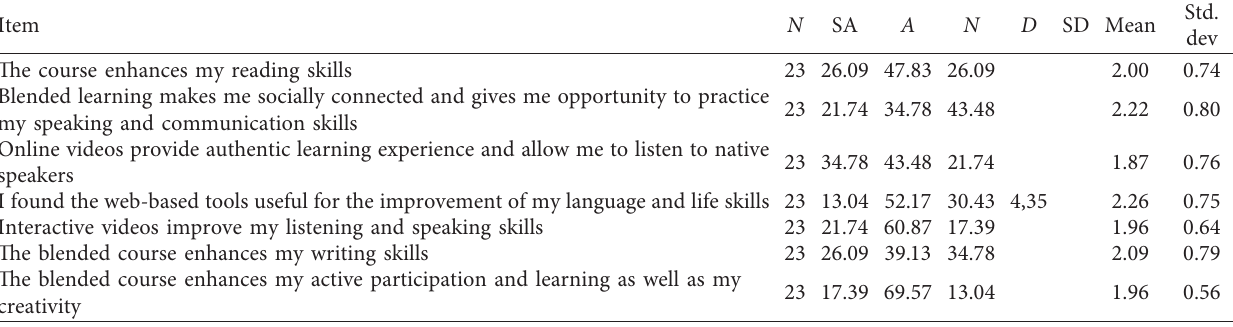
Table 4: Descriptive statistics of responses towards the syllabus and language